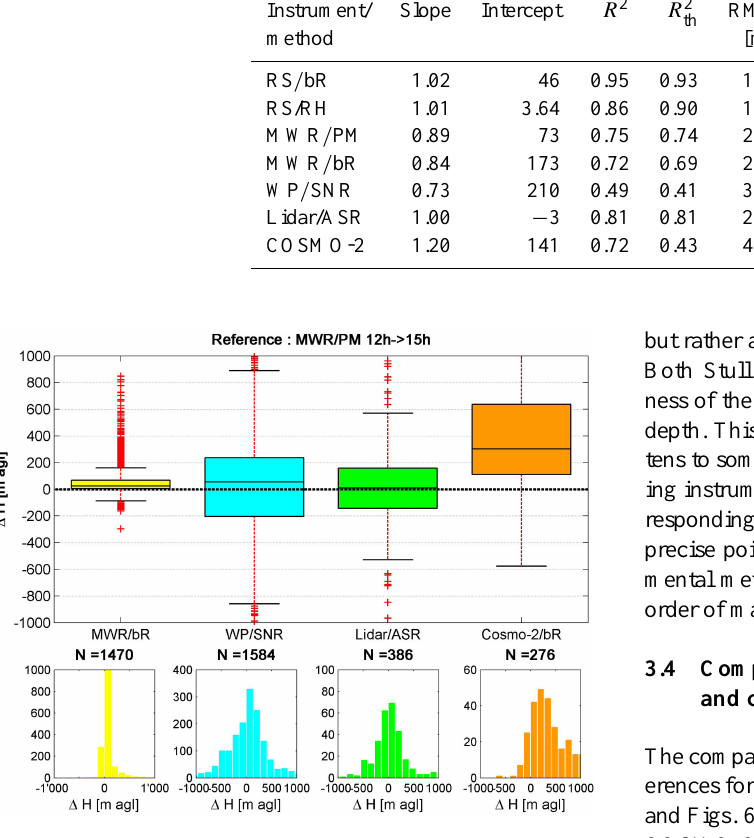
Figure 7. Same as Fig. 6 but between 12:00 and 15:00UT and with MWR/PM taken as the